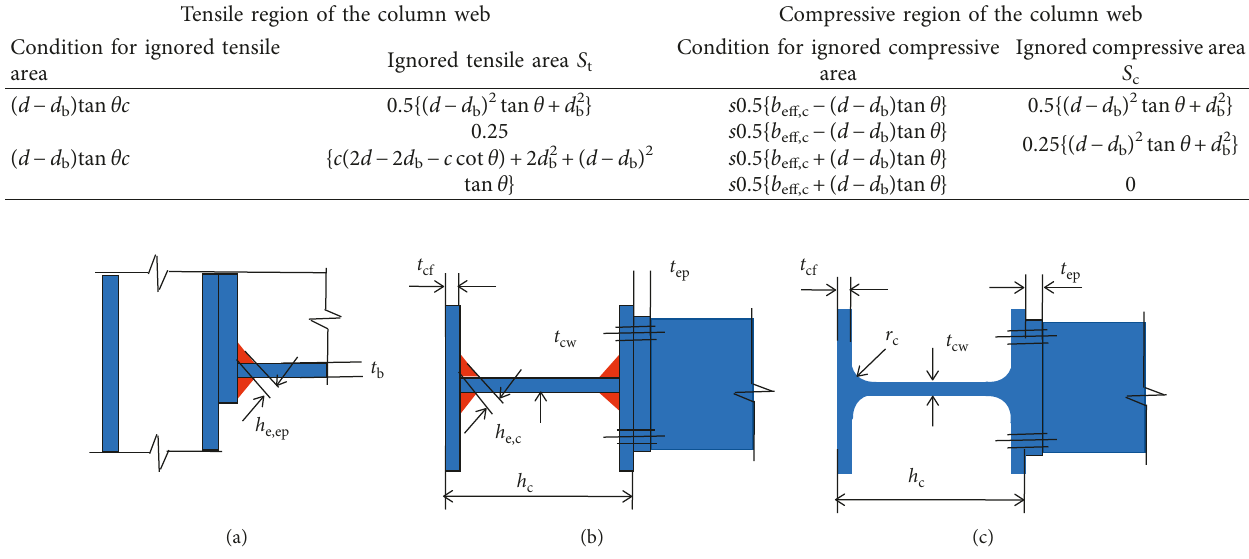
Figure 14: Sizes of the column web. (a) Front view of the welded joint. (b) Top view of the welded joint. (c) Top view of the hot-rolled joint.